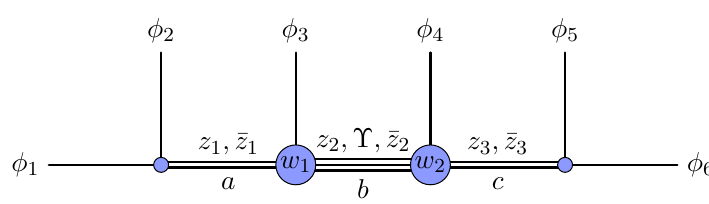
Figure 1 . Six point function with external scalars in the comb channel. The z i , ¯ z i , w i and Υ type of cross ratios are naturally associated with one particular internal leg or vertex of the OPE diagram, see [32] for